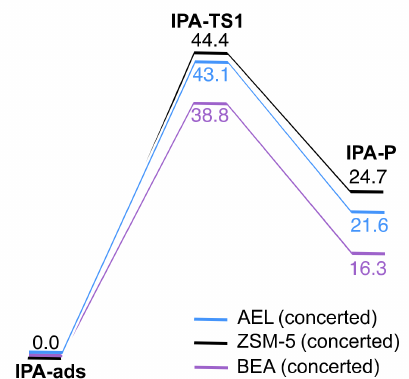
Figure 7. Energies ( ∆ E, kcal mol − 1 ) are depicted along the reaction coordinate for the dehydration of IPA, following the concerted mechanism types depicted in Kim et al. [22]. “IPA-ads” refers to IPA adsorbed at the active site of the relevant